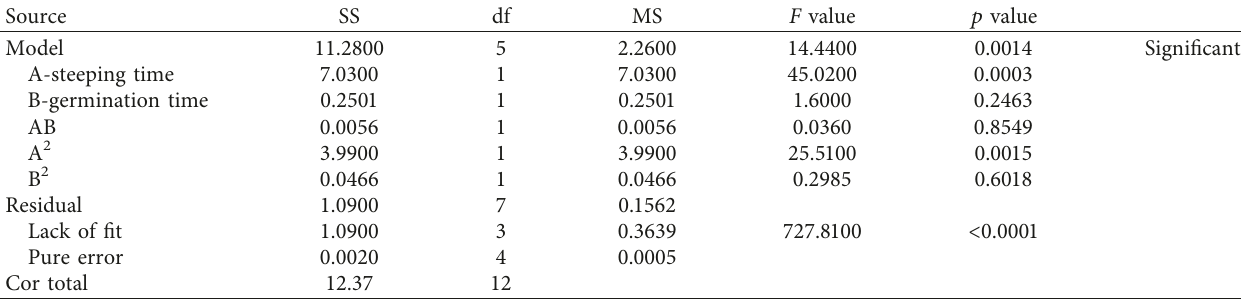
Table 4: ANOVA results for quadratic modelling of Brix content during barley